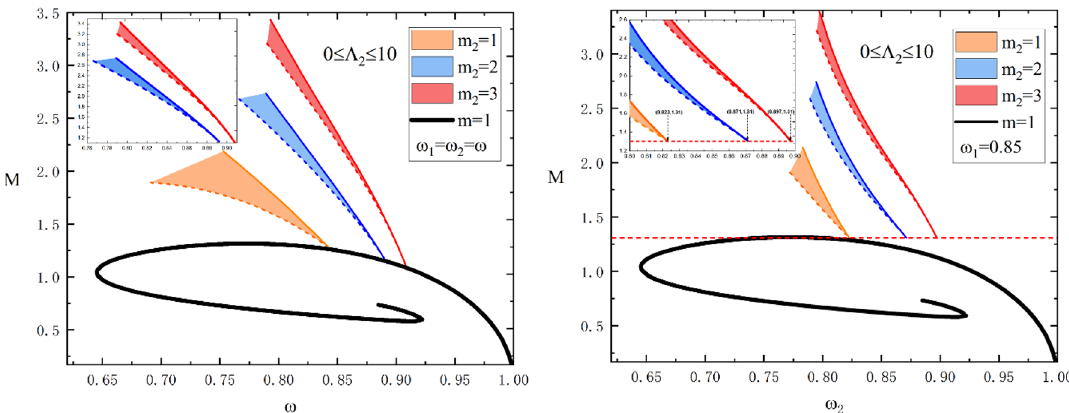
Figure 4 . Left : the mass M of the SIMBSs as a function of the synchronized frequency ω with the azimuthal harmonic indexes m 2 = 1 , 2 , 3 . Right : the mass M of the SIMBSs as a function of the nonsynchronized frequency ω 2 with ω 1 = 0 . 85 . The horizon red dashed line indicates the mass M = 1 . 31 . In both panels, the dashed and solid lines stand for Λ 2 = 0 and Λ 2 = 10 , respectively. The black spiral curve indicates the ground state with m = 1 and all solutions have µ 1 = 1 , µ 2 = 0 . 93 , m 1 = 1 .